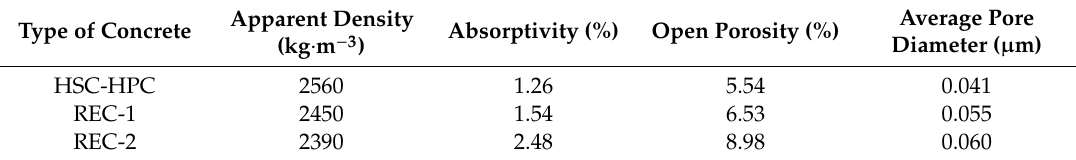
Table 8. Properties of recycled aggregate concrete and the HSC-HPC concrete.